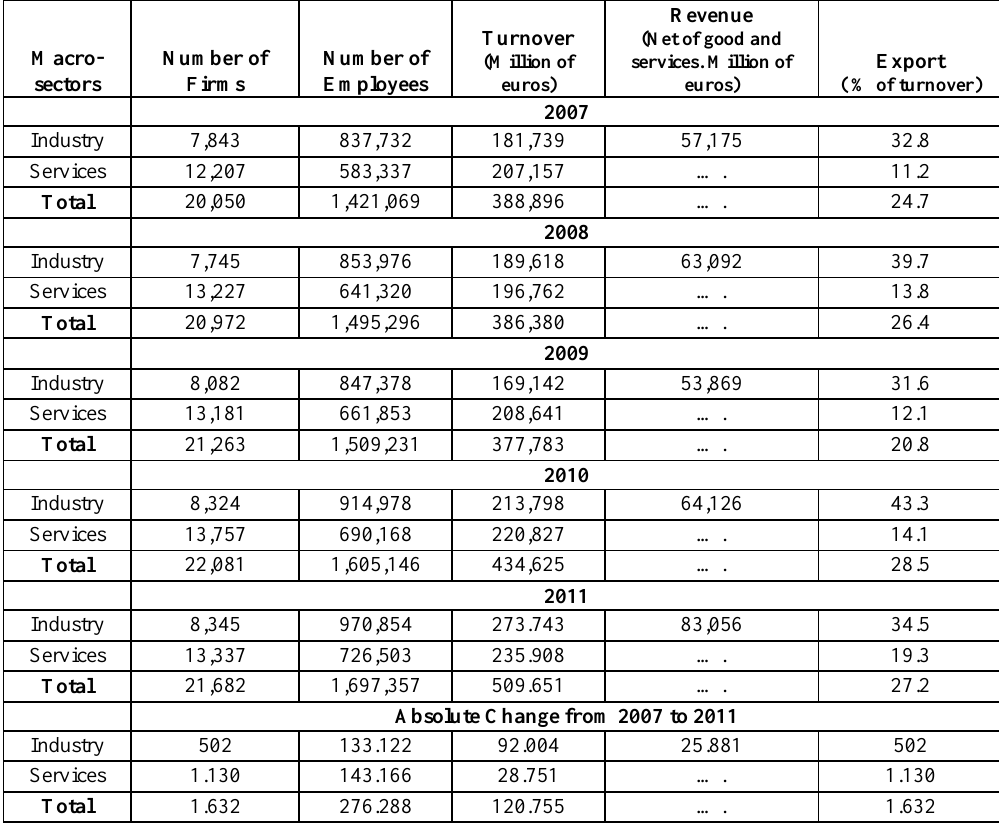
Table 1: Characteristics of Italian Affiliates Abroad